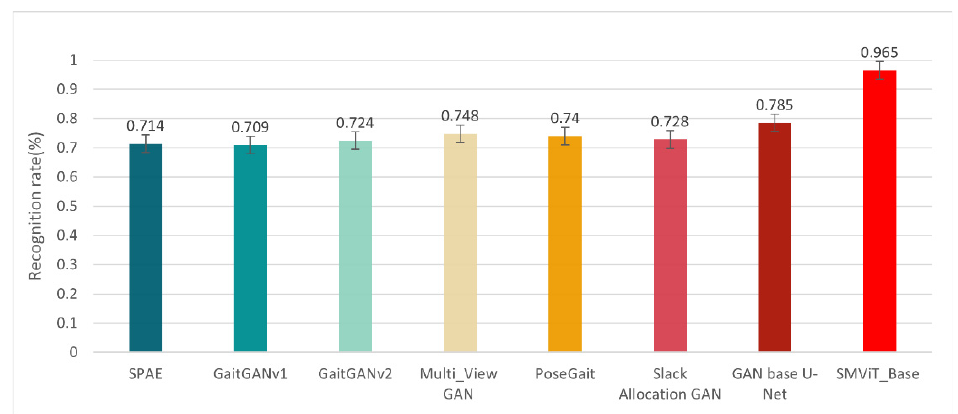
Figure 8. Comparison of the average validation rates of the model from multiple views.